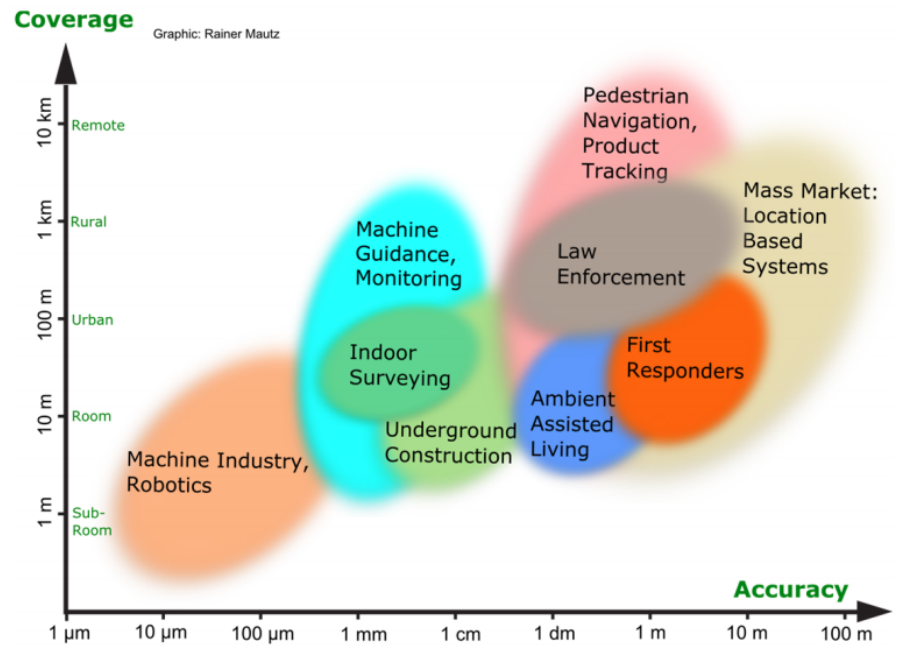
Figure 2. Overview of positioning requirements in terms of accuracy and area coverage. Adopted from